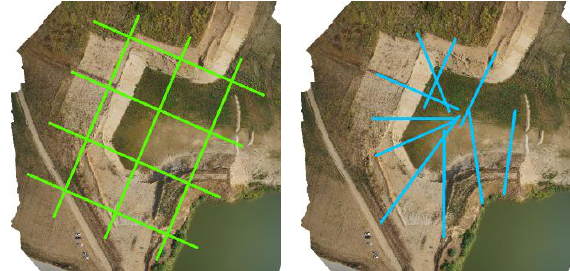
Figure 4. Flight plans for Blocks 1 and 2 (left) and for Blocks 3 and 4 (right)